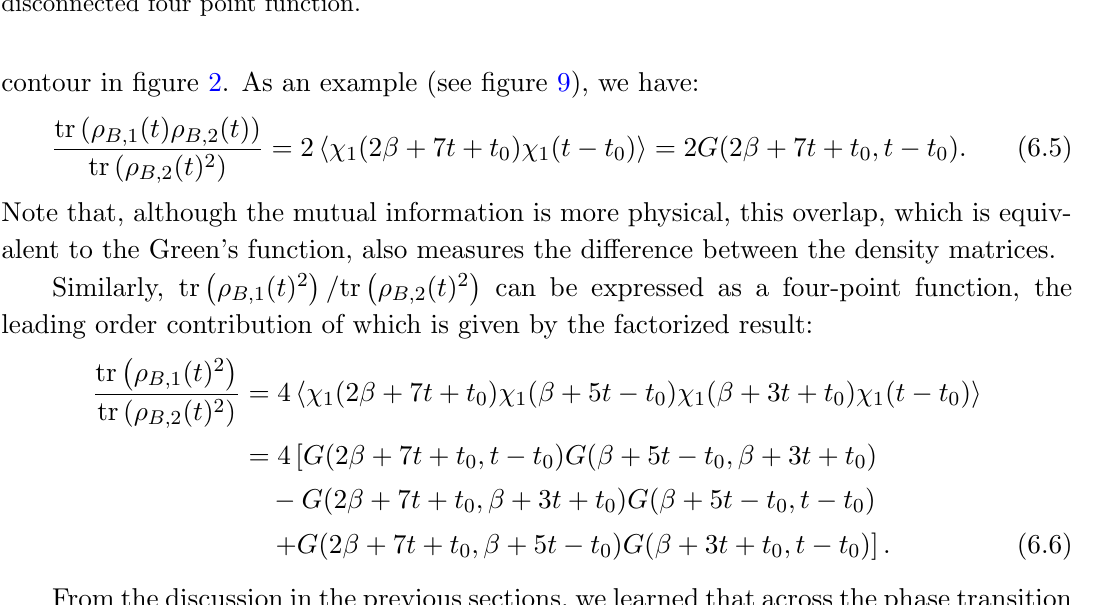
Figure 10. Numerical results on the R(cid:19)enyi mutual information and the overlap for t 0 = (cid:12) < t Page (blue dots), with V 2 =J = 0 : 05 ; (cid:12)J = 4 ; (cid:3) = 5 J . The black dashed line is the analytical result using the Schwarzian four point function and the red dashed line is the result coming from the disconnected four point